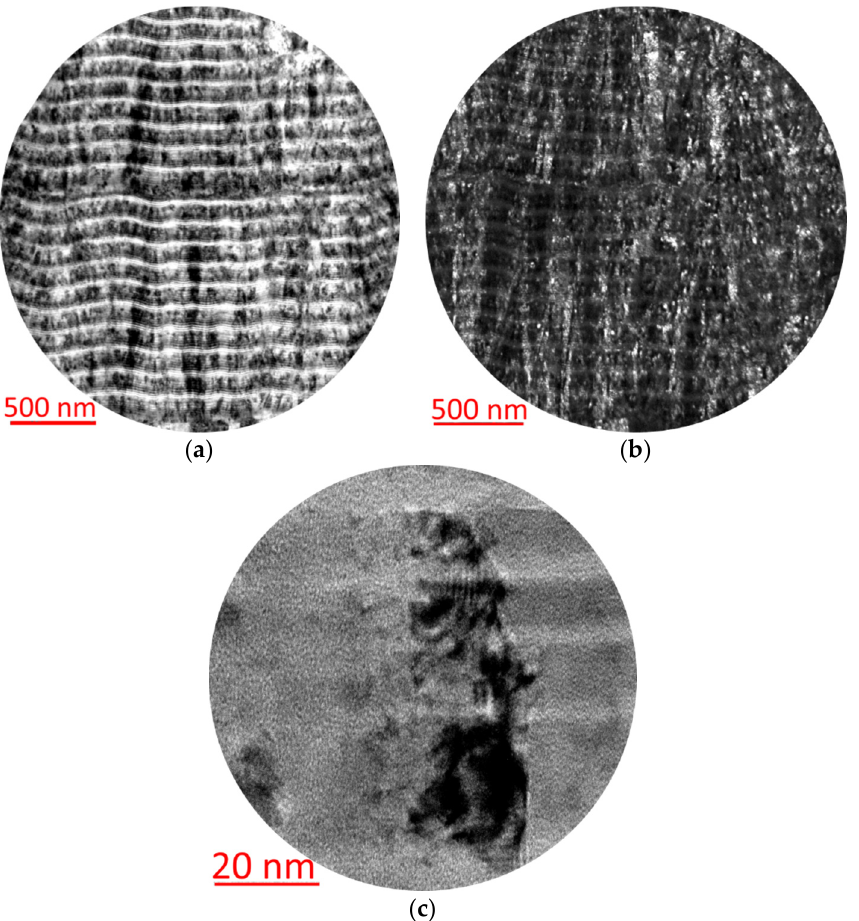
Figure 4. TEM micrograph of Ti-TiN-(Ti,Cr,Mo,Al)N coating and study of the influence of the nanolayer structure of the coating on its crystalline structure. ( a ) nanostructure ( b ) nanostructure in reverse contrast image ( c ) individual grain in a nanostructure.